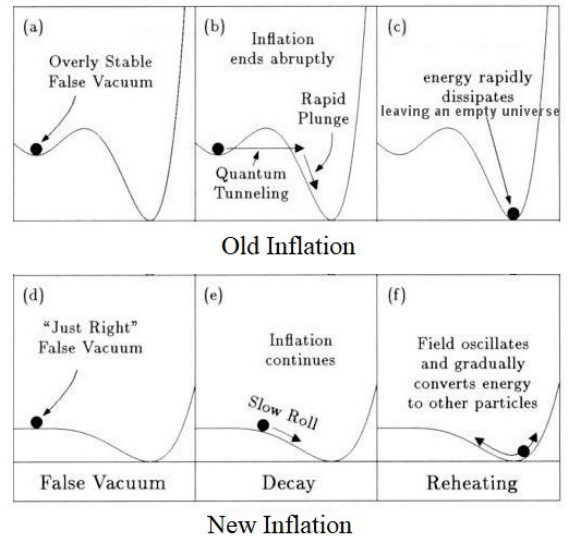
Figure 18. How the universe springs into being through a scalar field. Old Inflation: ( a ) The scalar field is in stable false vacuum ( b ) It shows that the scalar field causes inflation through quantum tunneling which comes to an end suddenly ( c ) Due to abrupt ending of inflation, energy is dissipated without evolution of the universe or an empty universe results. New Inflation: ( d ) The scalar field begins in right false vacuum ( e ) Despite quantum tunneling, the scalar field decays by slowly rolling down towards its minimum hence the name slow roll inflation ( f ) The energy does not dissipate, instead reheat occurs and the universe evolves to radiation and other